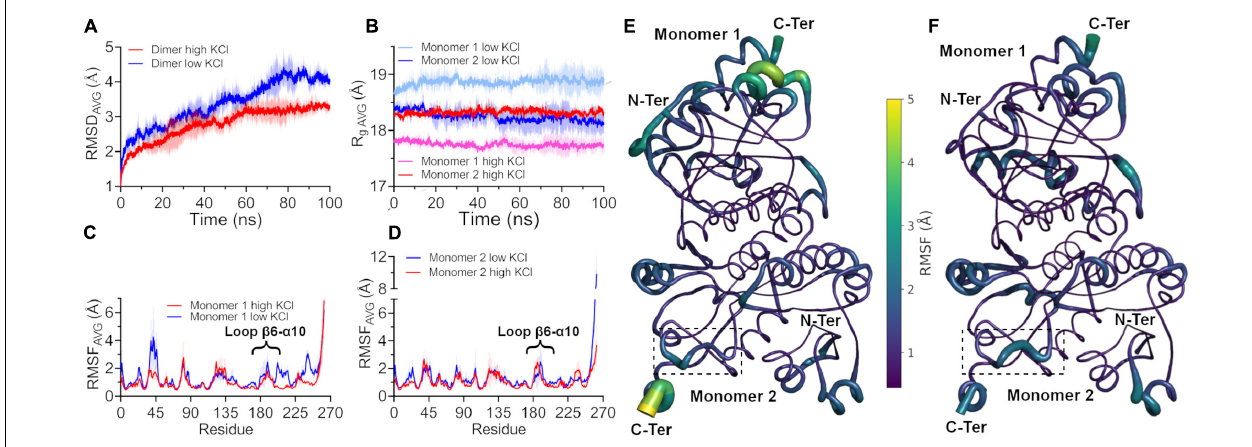
FIGURE 5 | Conformational dynamics of Hv G6PDH at different salt concentrations. The colored lines show the average root mean square deviation (RMSD) values of three 100-ns replicates without spatial restriction on ligands; ± SD is shown as a shaded area. (A) Average RMSD values of the Hv G6PDH dimer in the presence of low salt (blue) and high salt (red) from classical molecular dynamics. (B) Average radius of gyration ( R g ) of each Hv G6PDH monomer. The colors with red hues represent the simulation with high salt, and the blue ones represent simulations in the presence of low salt. Monomer 1 is represented by pink and light blue and monomer 2 by red and blue. (C,D) Average root mean square fluctuation (RMSF) values for monomers 1 and 2, respectively, at both high and low salt concentrations. Both monomers exhibit regions with high RMSF values, such as the β 6- α 10 loop. (C) Particularly, in the case of monomer 1, these regions display higher RMSF values at low salt but are stabilized at high salt concentrations. (E,F) Putty structural representation of the Hv G6PDH dimer with the average RMSF values depicted as a color scale for low and high salt molecular dynamics, respectively. The β 6- α 10 loop of monomer 2 is displayed by a dotted square.